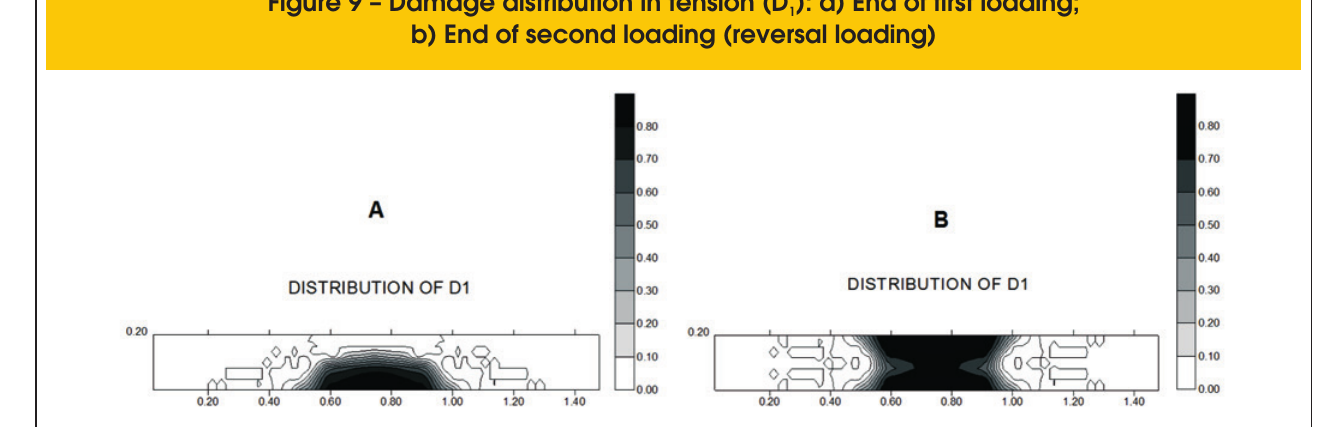
Figure 9 – Damage distribution in tension (D ): a) End of first loading;